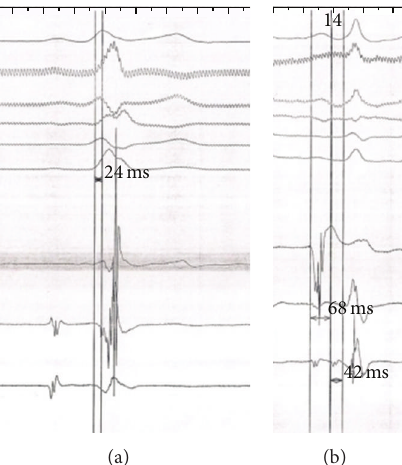
Figure 5: After the use of isuprel ((b) HV was 42 ms), HV interval was longer than the basal state ((a) HV was − 24ms). The isuprel accelerated atrioventricular conduction.